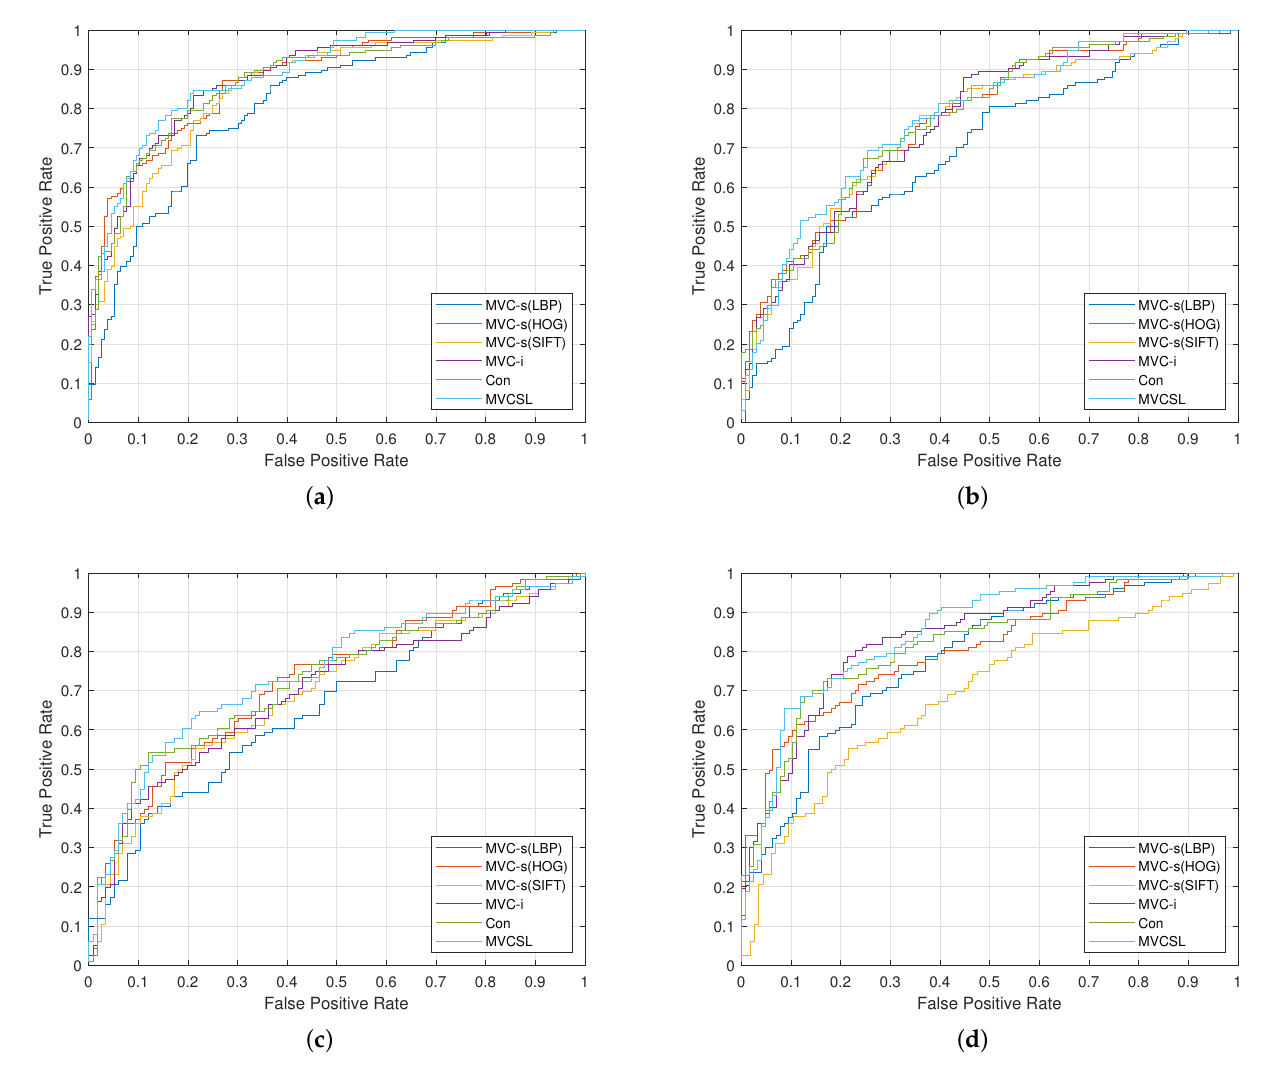
Figure 5. ROC curves of the proposed MVCSL and baseline methods on the KinFaceW-I dataset.